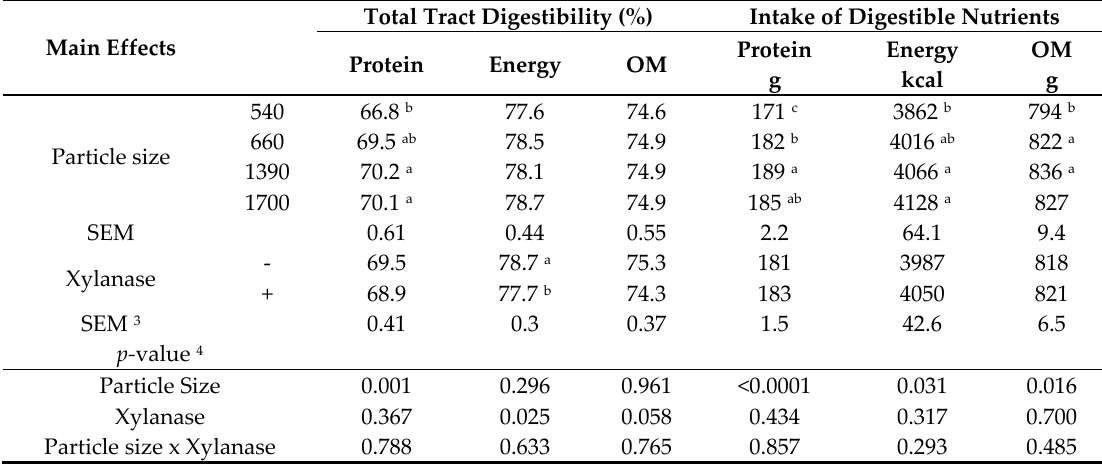
Table 7. Effects of particle size and xylanase inclusion on 21-day apparent total tract digestibility and intake of digestible nutrients 1,2